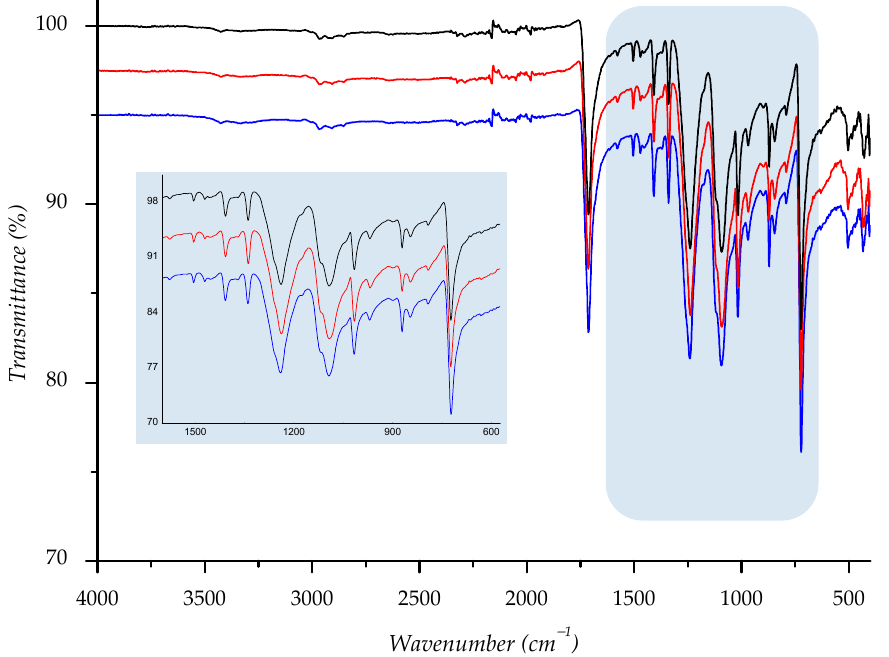
Figure 14. IR spectra of investigated sample F1 ((—) = starting material; (—) = material aged in sun; (—) = material aged in shade) with enlarged fingerprint region (colored in blue).